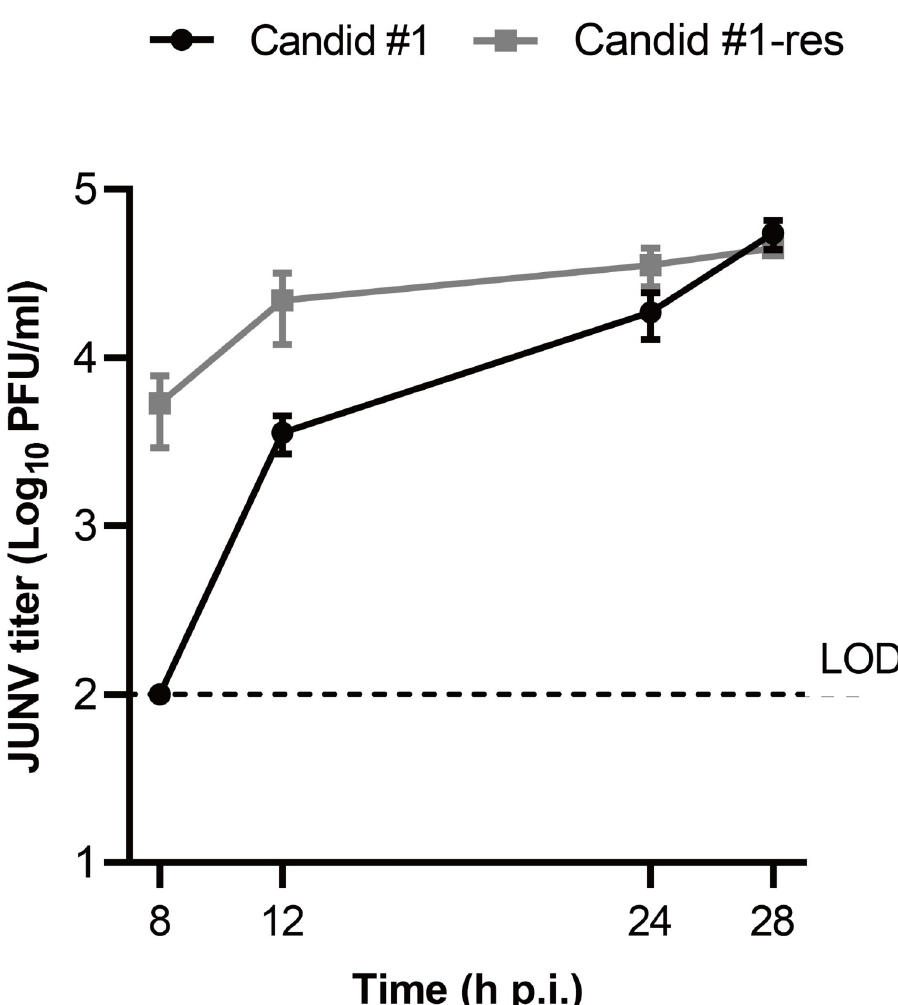
Fig 3. JUNV Candid #1-mutant virus replication begins at an earlier time point. To determine the one-step growth kinetics of favipiravir resistant JUNV, 293T cells were infected with either Candid #1 or Candid #1-mutant (MOI: 0.1). In order to synchronize infection, cells were incubated on ice for 30 minutes. Cells were then washed with PBS ( − ), and pre-warmed DMEM containing 10% FBS was added. Supernatant was collected at the indicated time points. Titers were determined by plaque assay. Error bars indicate ± SD, three independent experiments in duplicates (n = 6) were performed. Statistical significance was determined by 2-way ANOVA test ( P < 0.0001); LOD, limit of detection (100